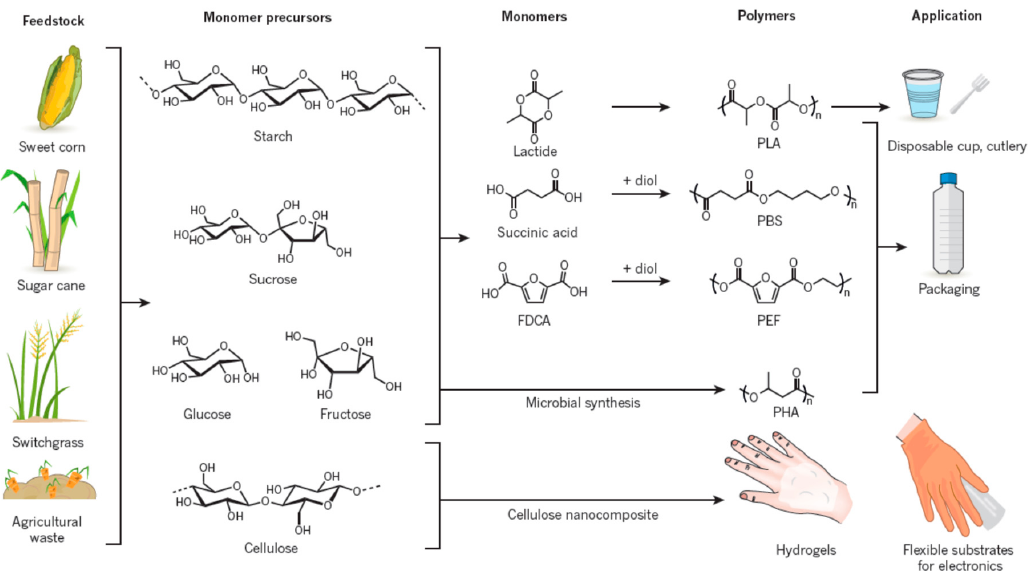
Figure 1. Sustainable polymers from polysaccharides and agricultural waste. Reproduced with permission from [5], Springer Nature, 2019.